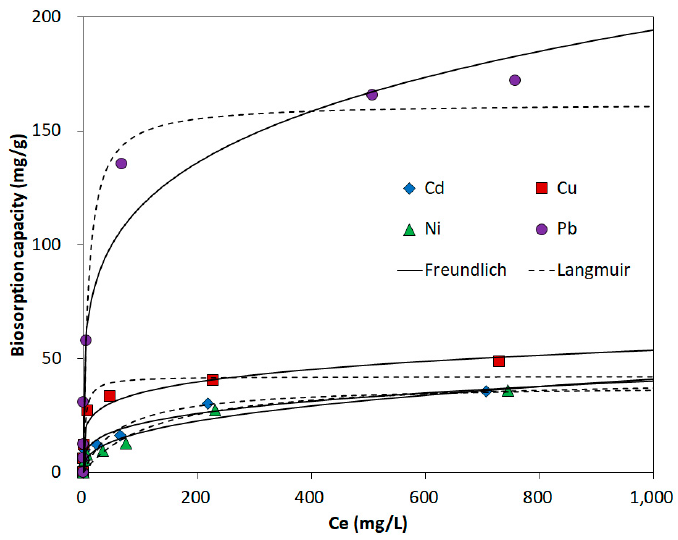
Figure 6. Equilibrium sorption of Cd 2+ , Cu 2+ , Ni 2+ , and Pb 2+ by 1 M NaOH-treated H. fusiformis. Table 4. Langmuir and Freundlich model parameter of Cd 2+ , Cu 2+ , Ni 2+ , and Pb 2+ sorption by 1 M NaOH-treated H. fusiformis.